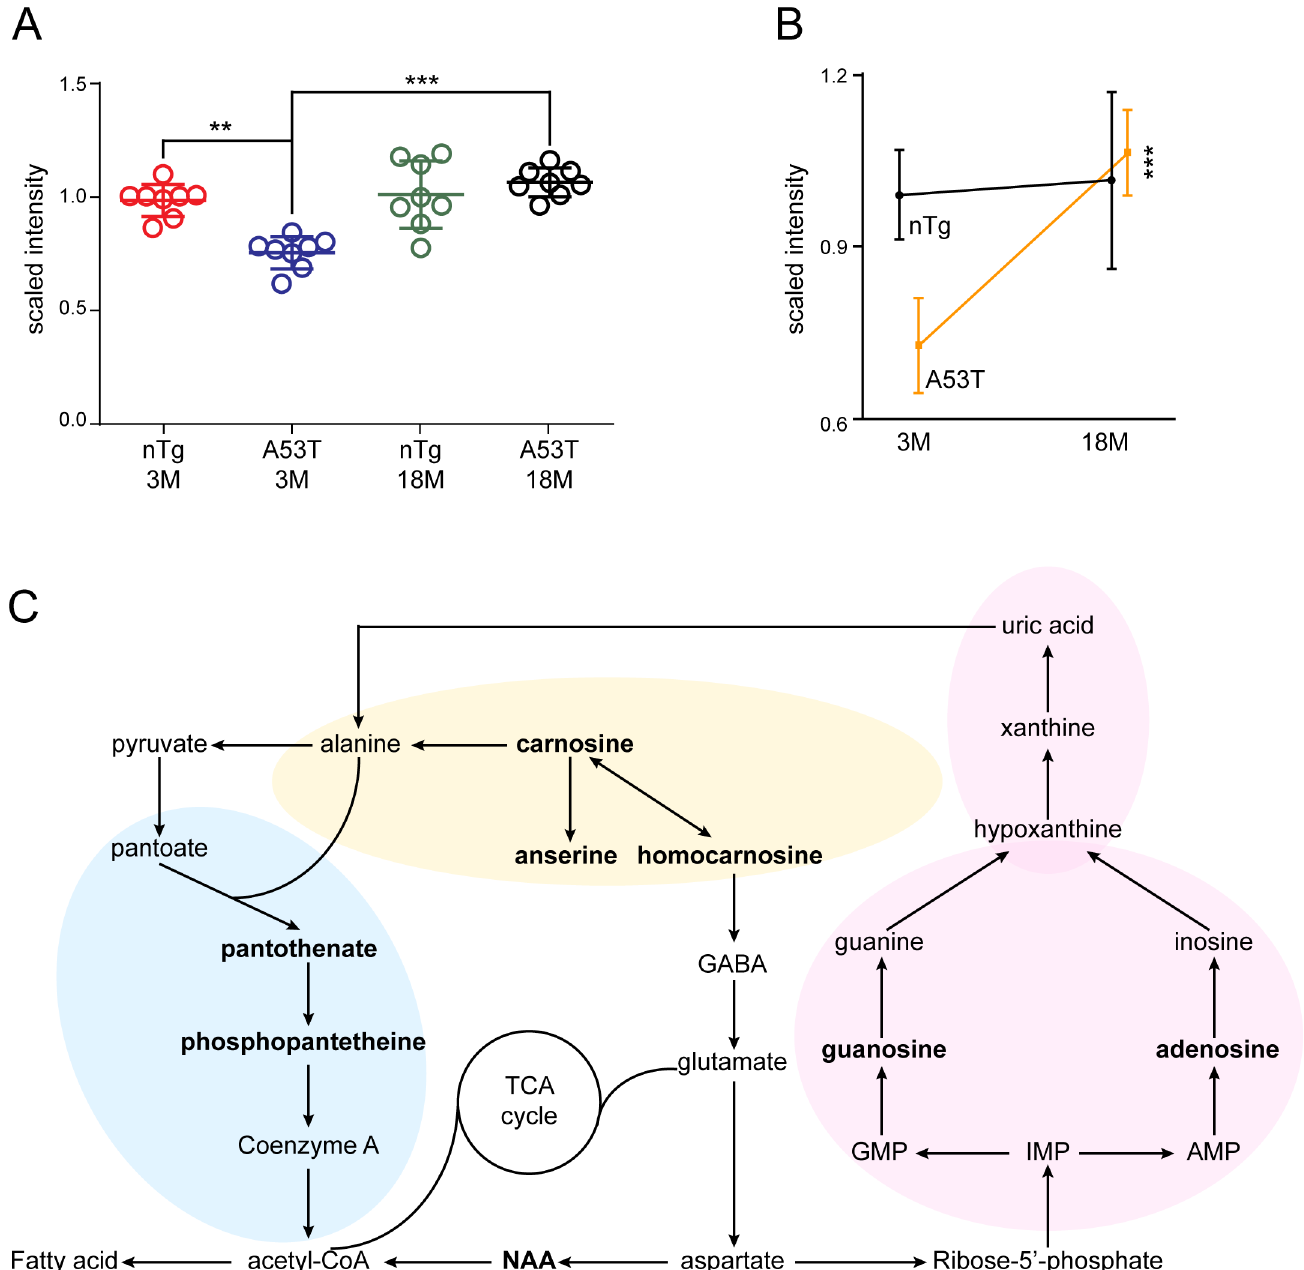
Fig 5. Guanosine metabolism is affected by both aging and A53T mutation. (A) Scatter plot depicts the alteration of guanosine levels in different age and genotype groups. One-way ANOVA test, ** q value < 0.01; *** q value < 0.001. (B) Line graph highlights the age-dependent changes of guanosine in A53T and nTg mice. One-way ANOVA test, *** q value < 0.001. (C) Schematic diagram summarizes the alanine metabolic (in yellow shade) and acetyl-CoA biosynthesis (in blue shade) pathways mainly affected by aging, and the purine metabolic (in pink shade) pathway influenced by both aging and genotypes. The metabolites highlighted with the bold font represent the ones differentially altered between groups (q value < 0.05 in two-way ANOVA